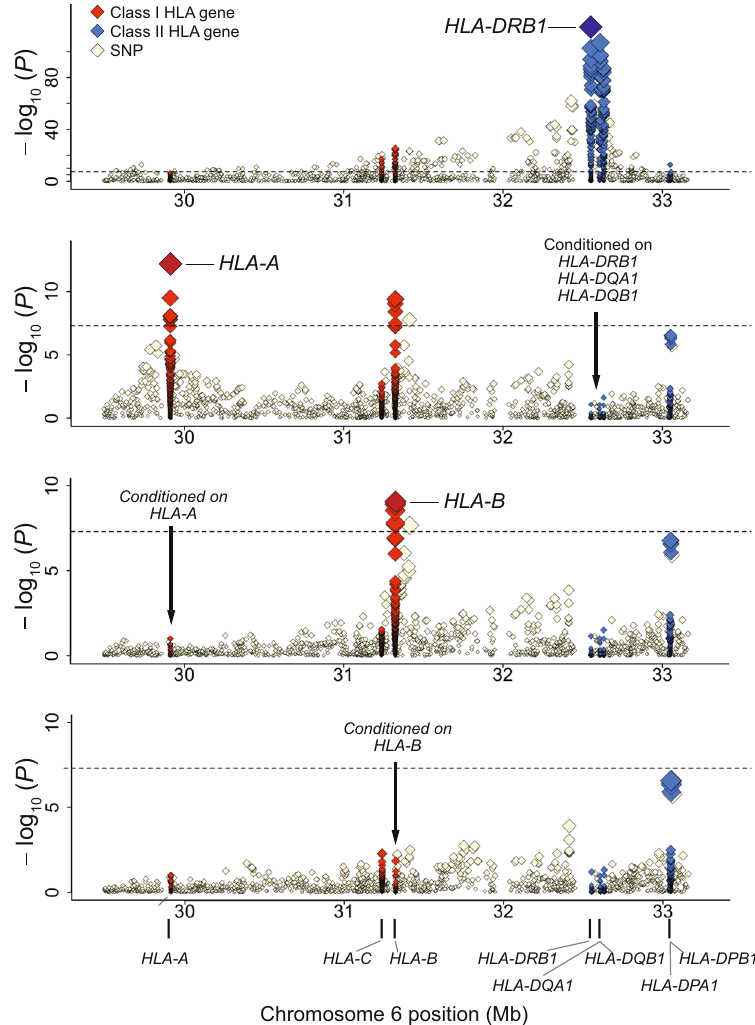
Fig. 5 Transethnic association plots of HLA variants with T1D in the MHC region. Diamonds represent − log 10 ( P values) for the tested HLA variants, including SNPs, classical alleles, and amino acid polymorphisms of the HLA genes. Dashed black horizontal lines represent the genome-wide signi fi cance threshold of P = 5.0 × 10 − 8 . The physical positions of the HLA genes on chromosome 6 are shown at the bottom. a – e Each panel shows the association plot in the process of stepwise conditional regression analysis: nominal results. a Results conditioned on HLA-DRB1 , HLA-DQA1 , and HLA-DQB1 . b Results conditioned on HLA-DRB1 , HLA-DQA1 , HLA-DQB1 , and HLA-A . c Results conditioned on HLA-DRB1 , HLA-DQA1 , HLA-DQB1 , HLA-A , and HLA-B . d Our study identi fi ed the independent contribution of multiple HLA class I and class II genes to the T1D risk in a trans-ethnic cohort, in which the impacts of class II HLA genes were more evident. Detailed association results are shown in Supplementary Data 1. HLA human leukocyte antigen, SNP single nucleotide